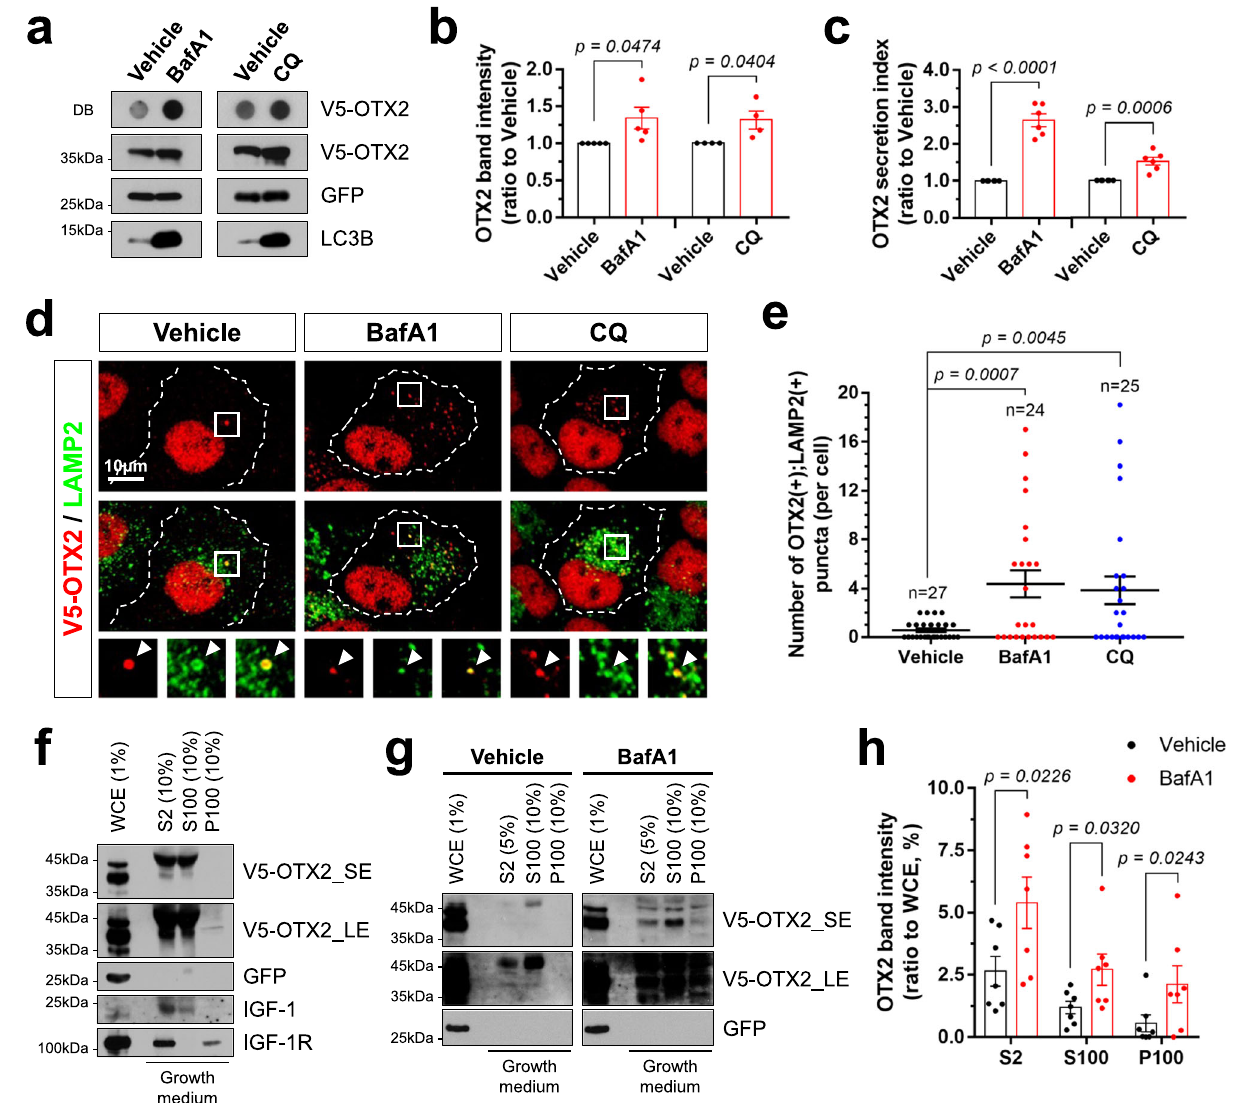
Fig. 2 | OTX2 is accumulated in the lysosome and extracellular space upon lysosomaldysfunction.a OTX2-HeLacellsweretreatedwithlysosomalinhibitors, BafA1(200nM)andCQ(50 μ M),orvehicle(DMSO)for24h.V5-OTX2secretedinto the growth medium of the cells was detected by dot blotting (DB) with an anti-V5 antibody(see details in Methods).Levelsof V5-OTX2andGFP inthe cells werealso detected by WB. Inhibition of lysosomal function by BafA1 and CQ was con fi rmed bydetectingtheaccumulationofLC3BbyWB.Thegraphsshowrelativeintensityof WB bands of OTX2 ( b ) and relative secretion index of OTX2 determined by DB ( c ), respectively. The columns represent means, and error bars denote SEM. Results were obtained from 6 independent experiments. d OTX2-HeLa cells treated with vehicle, BafA1, or CQ were stained with antibodies that recognize V5 and LAMP2. Images in the bottom row are magni fi ed versions of boxed areas in the top rows. Arrowheads indicate LAMP2-positive cytoplasmic puncta containing